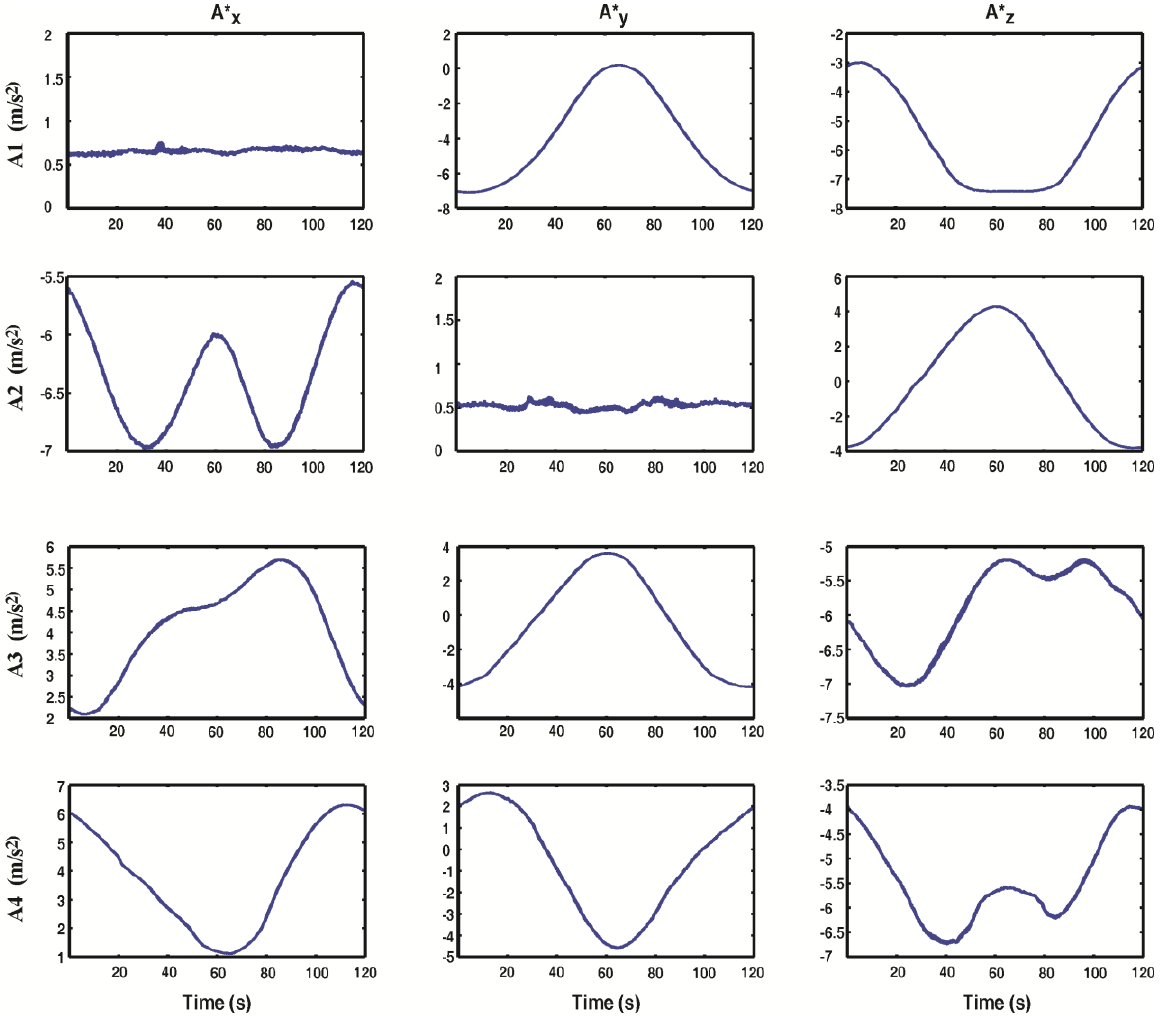
Figure 9. Filtered accelerometer